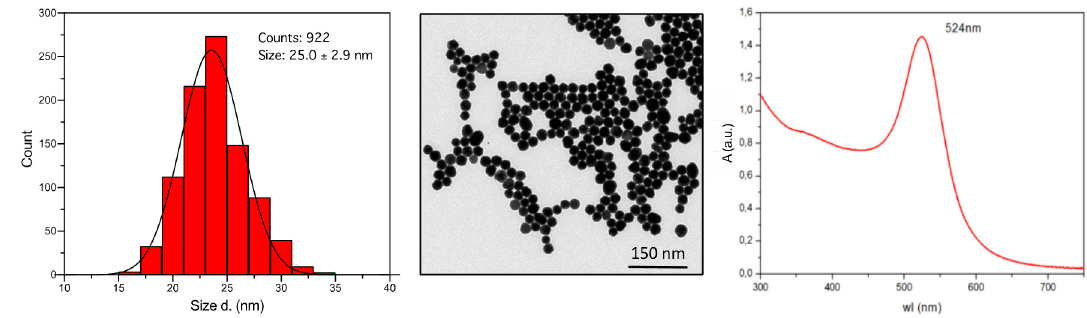
Figure 1. Characterization of 25 nm AuNP. Size distribution profile ( left panel ), STEM image ( central panel ), and UV-Vis profile ( right panel ) of AuNP following synthesis.